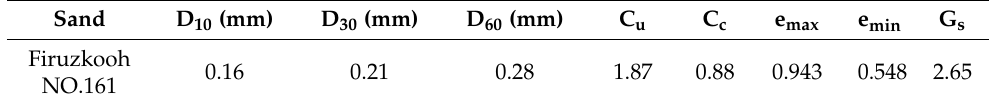
Table 1. Characteristics of Firoozkooh 161